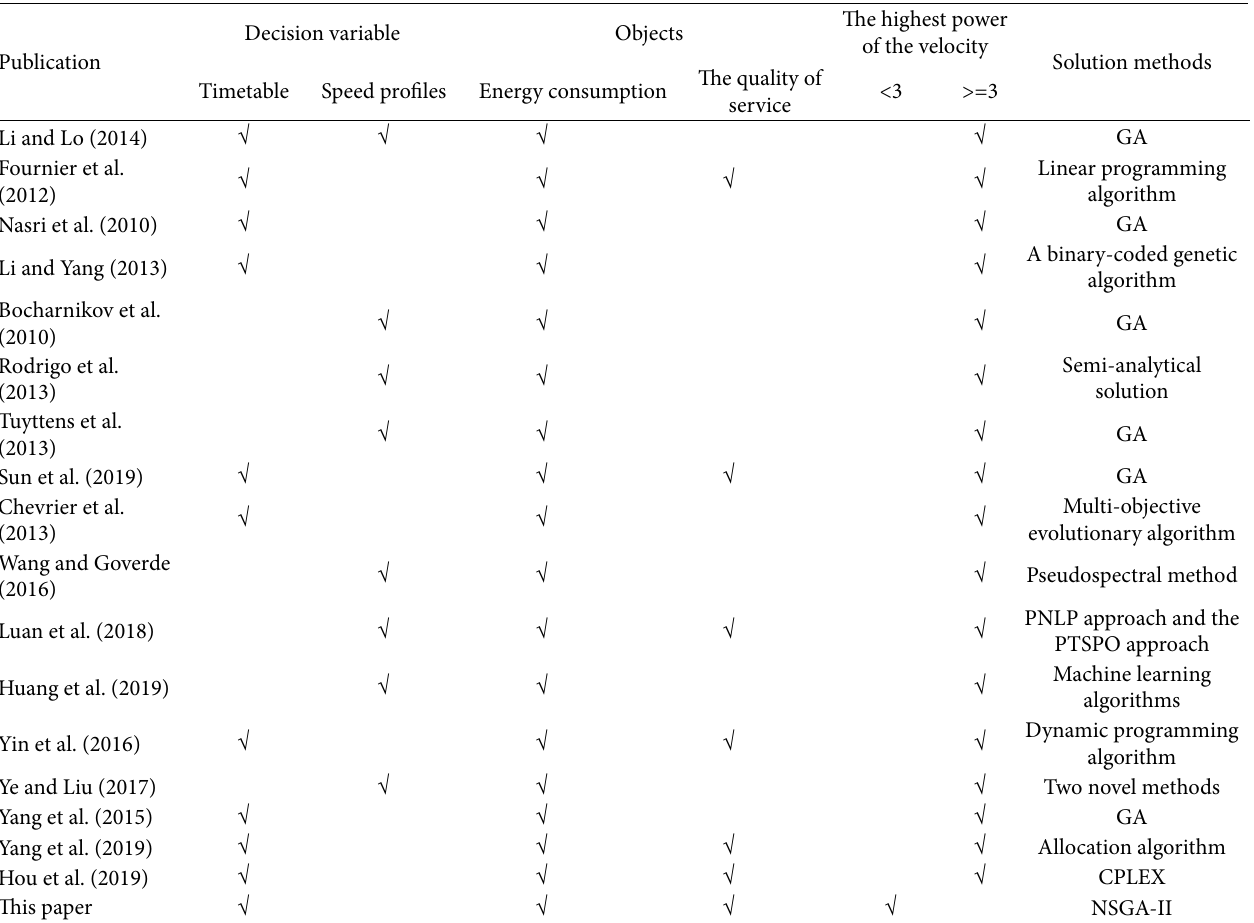
Table 1: Recent publications on energy-saving driving in comparison with this